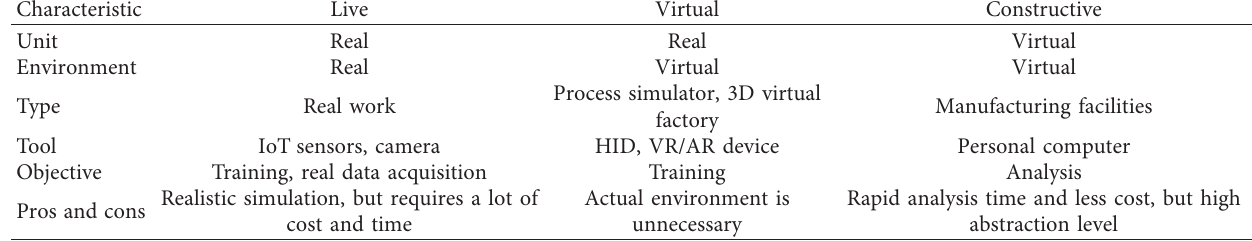
Table 1: Characteristics of live, virtual, and constructive.